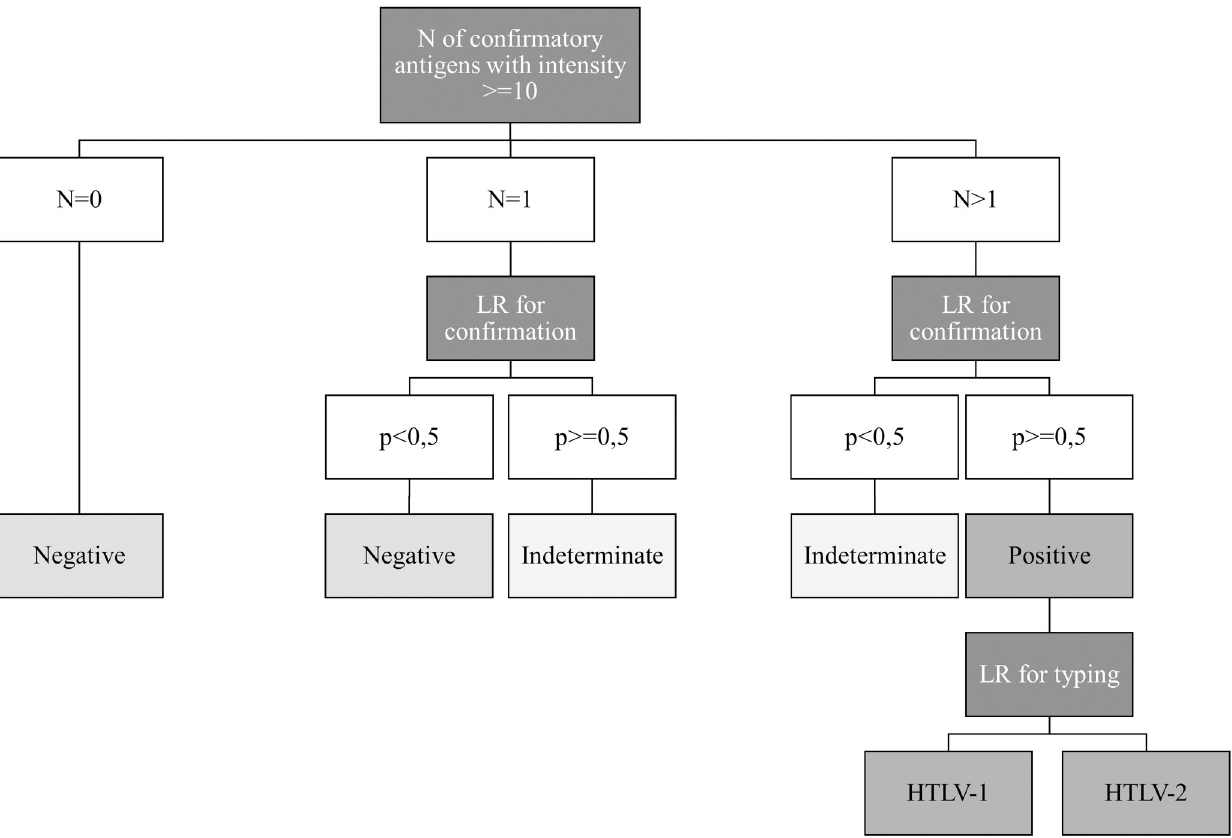
Fig 3. Simplified algorithm model for Multi-HTLV confirmation result. The decision tree representing the interpretation algorithm of the Multi-HTLV test, is divided into three steps. The first step is to classify the sample into three categories according to the number of confirmatory antigens with an intensity greater than or equal to 10. The second step is to apply the first logistic regression formula for confirmation to categorize samples with a number of reactive antigens greater than or equal to 1. Finally, the third step is to apply a logistic regression formula for typing, only on positive